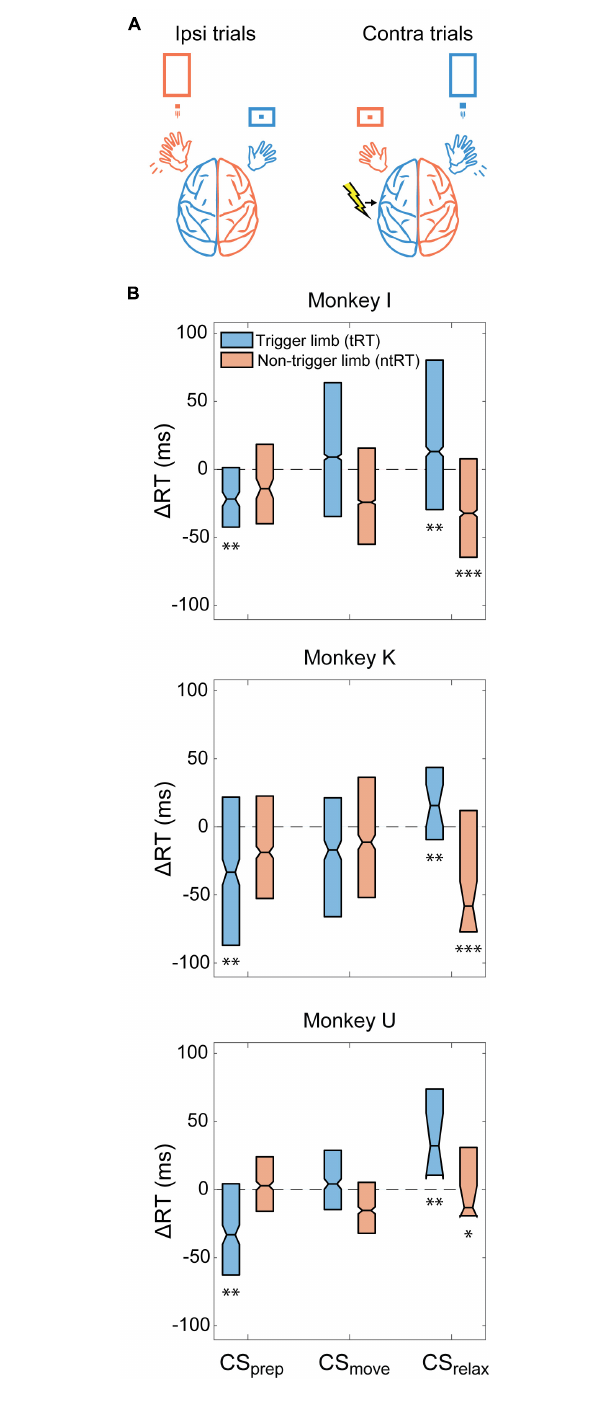
FIGURE 4 | Contralateral CS. (A) Example illustration of Contralateral CS and task relationship for left hemispheric stimulation. (B) Difference between RTs for trials during the Cond epoch and the median RT of the Pre epoch for each monkey ( (cid:49) RT). CS prep significantly decreased tRT in all monkeys. CS relax experiments produced bilateral effects, significantly slowing down tRT and speeding up ntRT. Significance is calculated in comparison with the no stimulation control experiments and only denoted if consistent across all animals ( ∗ p < 0.01; ∗∗ p < 0.001; ∗∗∗ p < 0.0001).